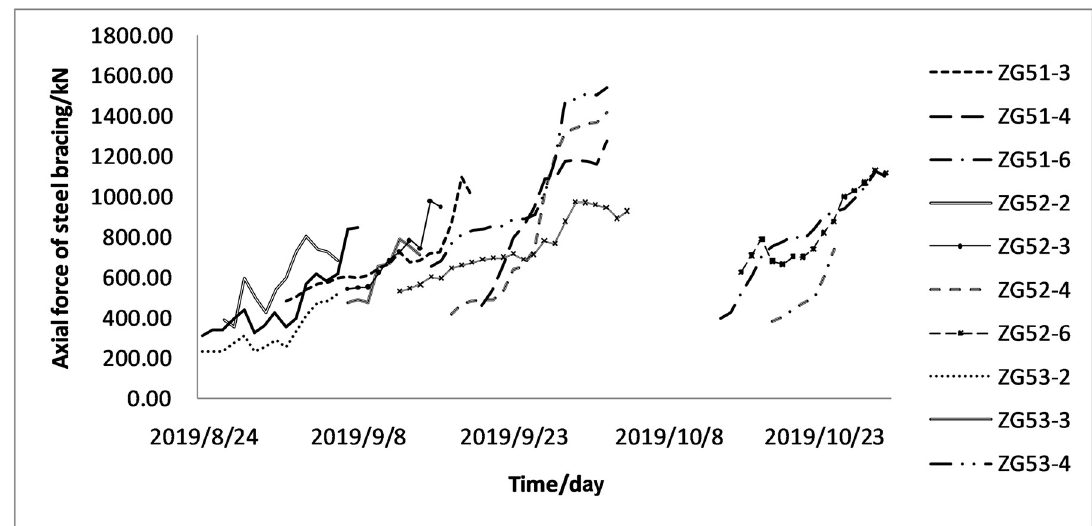
Fig 6. Variation of axial force in the early stage after steel bracing